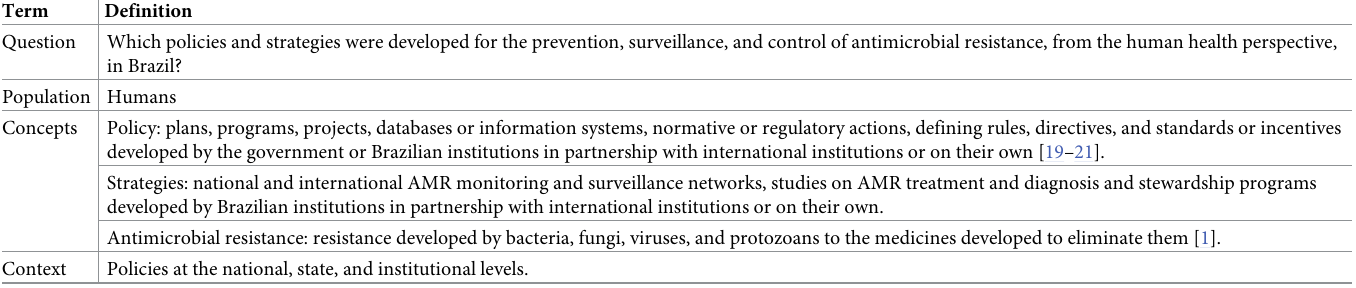
Table 1. Population, concept, and context for the review